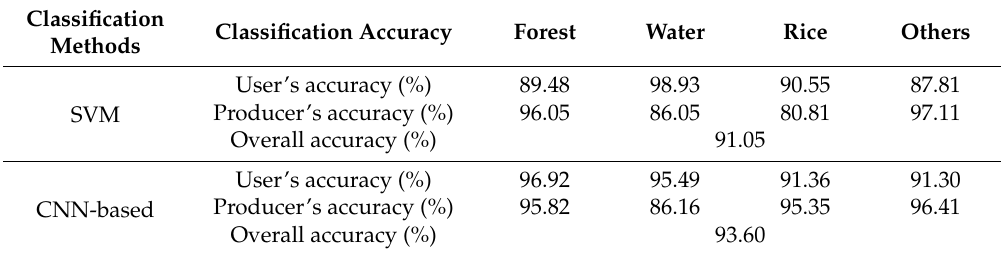
Table 4. Classification accuracies by using SVM and our proposed